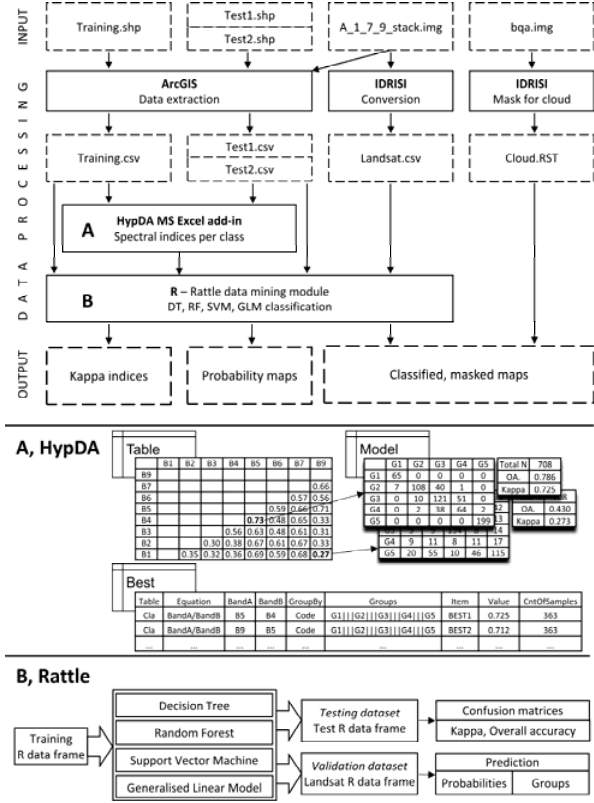
Figure 7. Classification procedure by the Debrecen team